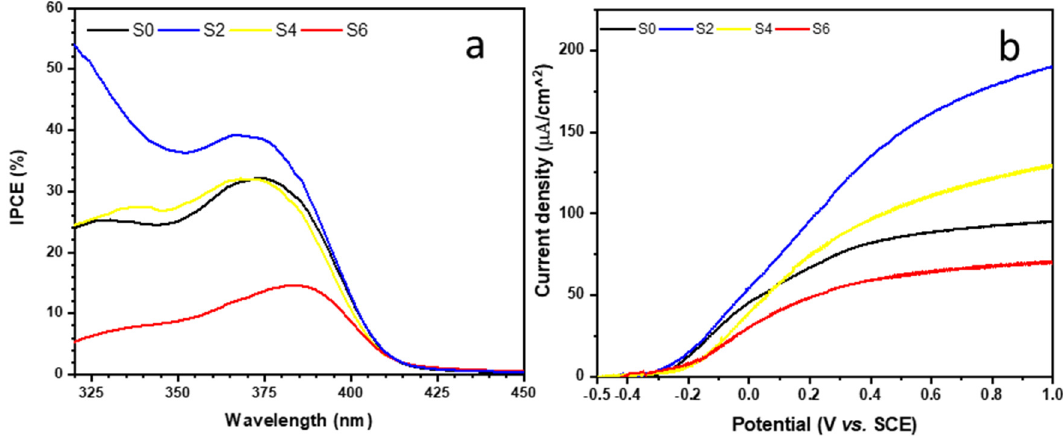
Figure 6. ( a ) Incident photon-to-current efficiency (IPCE) vs. irradiation wavelength curves and ( b ) linear sweep voltammetry (LSV) curves recorded from − 0.5 to 1 V vs. SCE at 5 mV s − 1 upon continuous Xenon light irradiation, measured for samples S0, S2, S4 and S6.